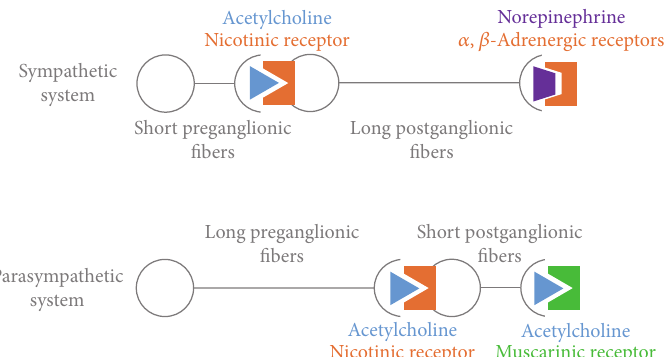
Figure 1: Schematic diagram of both sympathetic and parasympathetic divisions from the autonomic nervous system, showing the main receptors and neurotransmitters involved in each